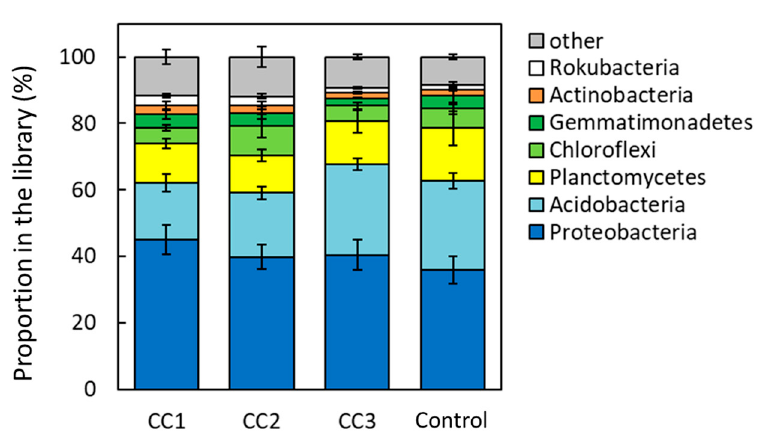
Figure 3. Composition of the soil bacterial communities of clear-cutting plots (CC1, CC2, and CC3) and the Control plot. Error bars show calculated standard deviations of each plot sample, including CC1, CC2, and the Control ( n = 6) and CC3 ( n = 8).